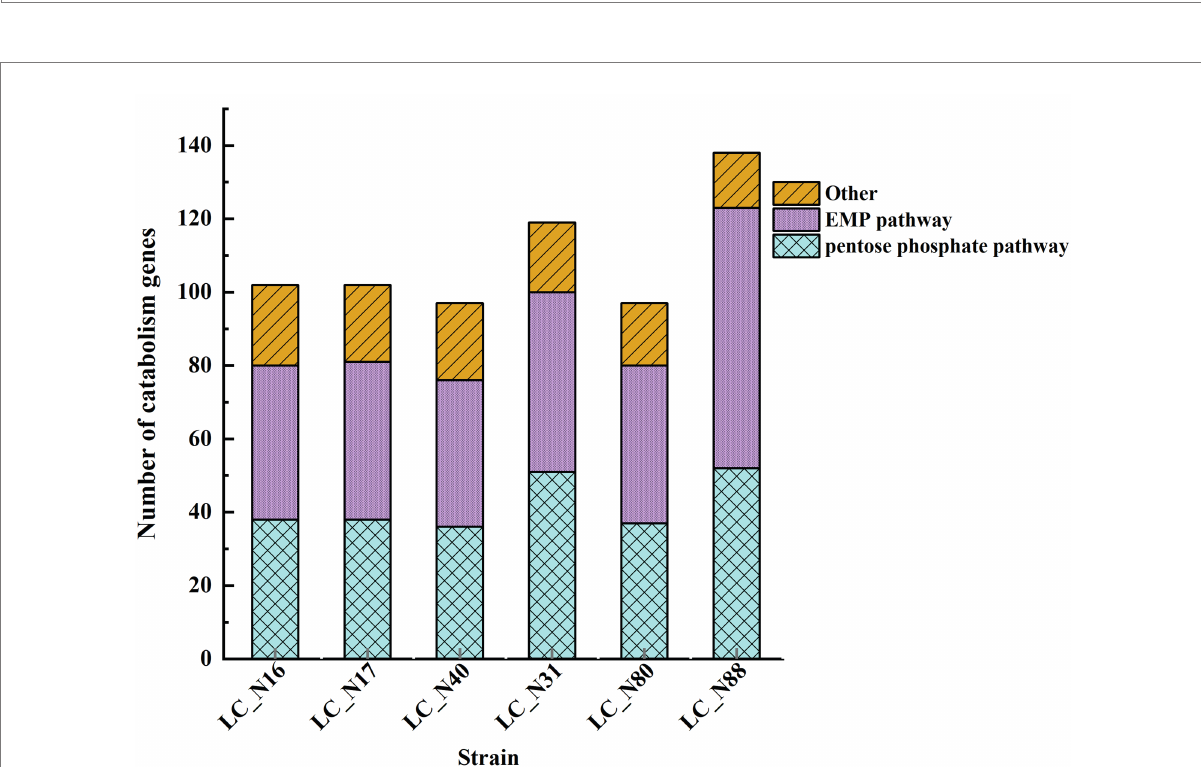
FIGURE 3 Genes related to lactose catabolism. The genes involved in the hydrolysis of lactose were related to three lactose metabolic pathways: 00052MN- Galactose metabolism (Supplementary Figure S1A), 00010MN-Glycolysis Gluconeogenesis (Supplementary Figure S1B), and 00030 M-Pentose phosphate pathway (Supplementary Figure